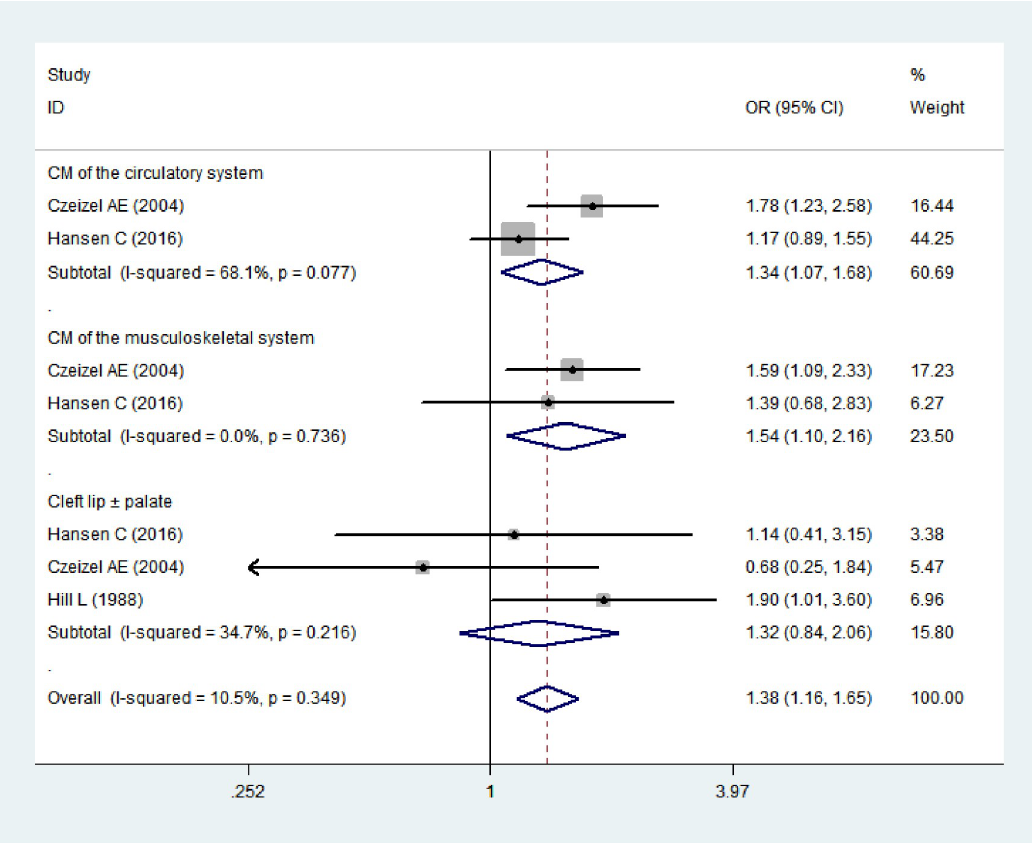
Fig 4. Forest plot with pooled odds ratios of the effect of maternal exposure to sulfonamides on offspring’s congenital malformations-subgroup analysis by types of malformations.